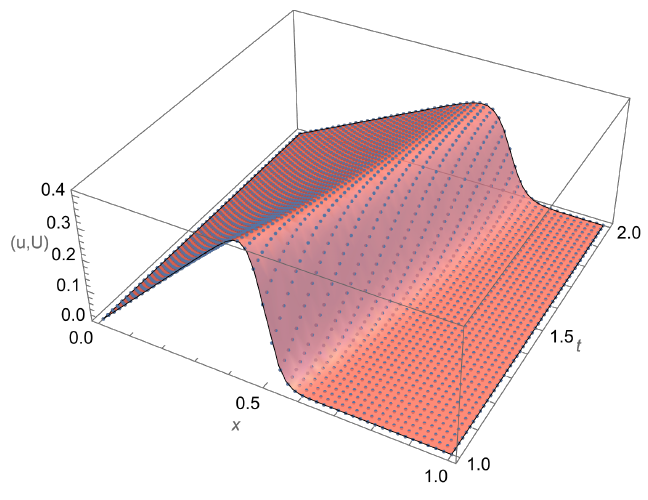
Figure 1. 3D Plot: N = NT = 50.